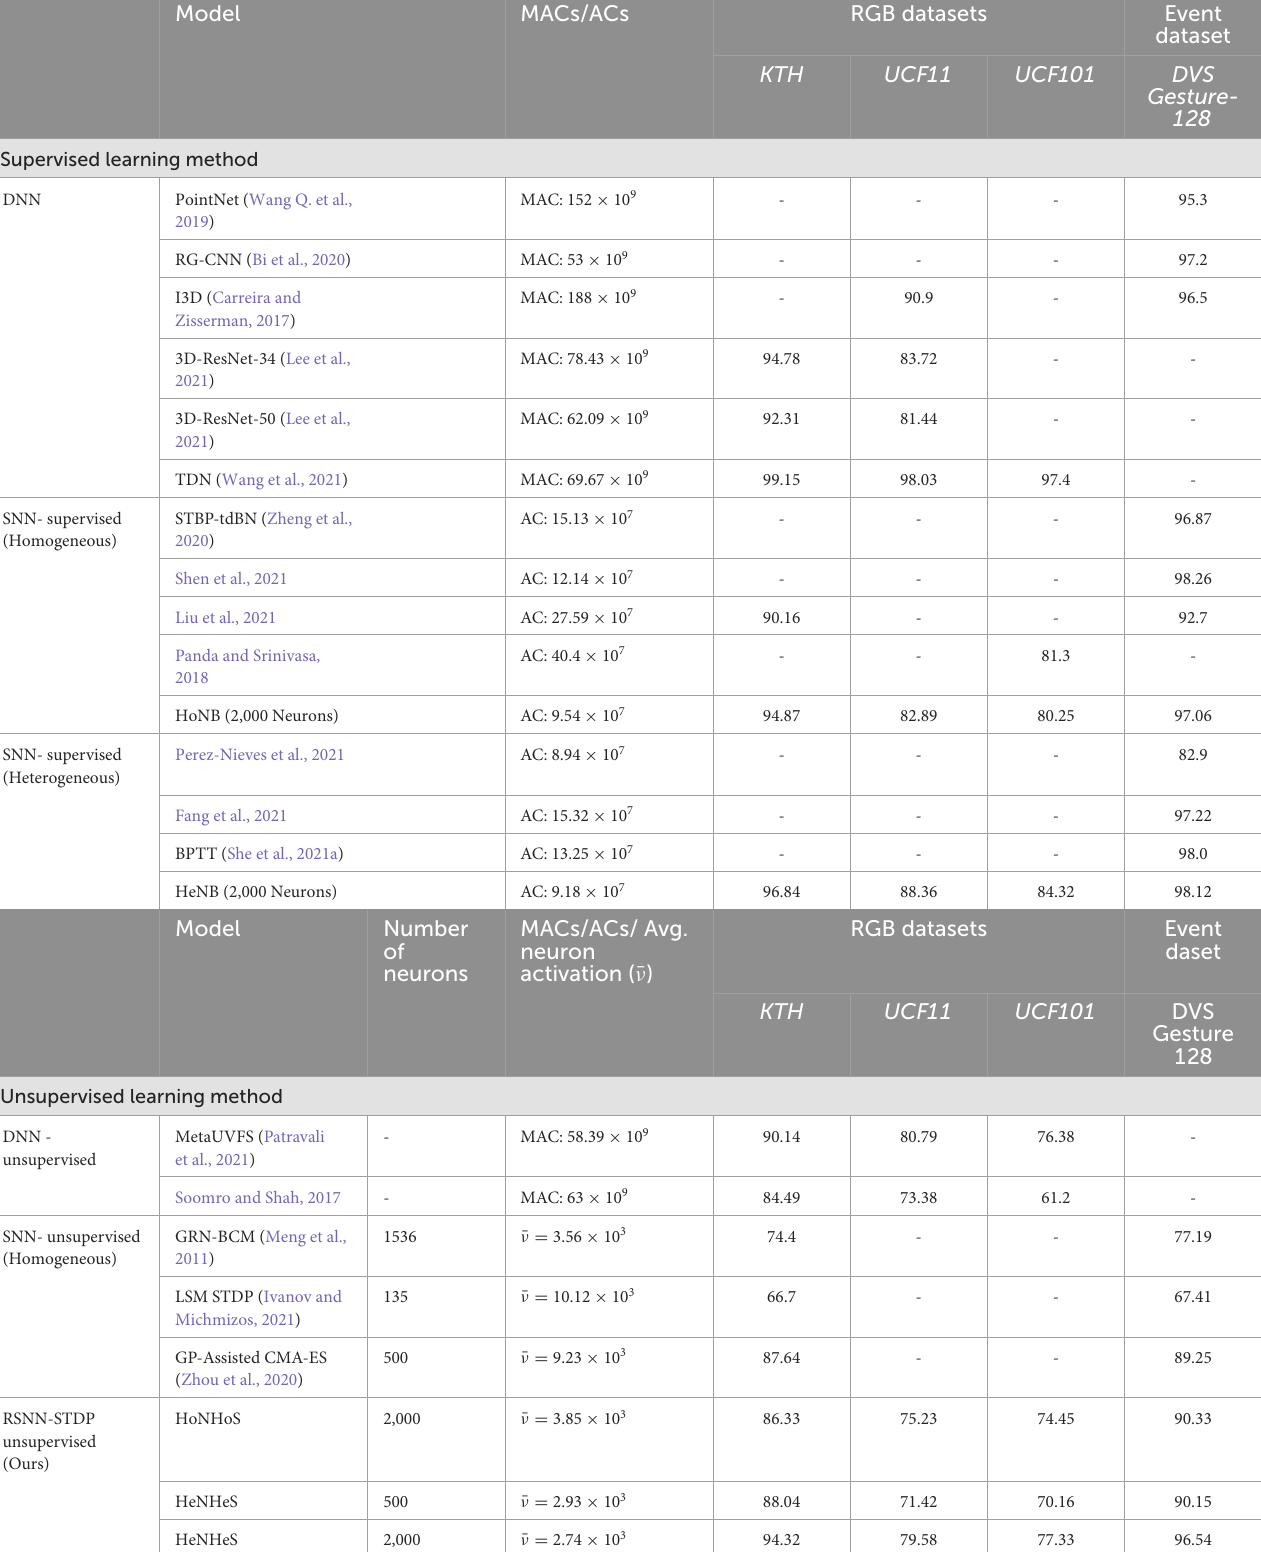
TABLE 2 Table showing the comparison of the performance and the model complexities for DNN and supervised and unsupervised SNN models. Model MACs/ACs RGB datasets Event